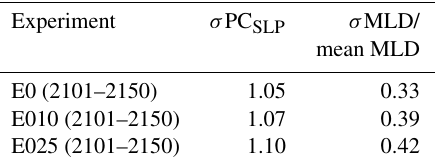
Table 3. Variation in the wintertime (DJFM) atmospheric forcing over the NE Atlantic during the shallow-ML regime as the standard deviation of the projection of the SLP composite pattern (Fig. 13) on the unprocessed SLP time series ( σ PC SLP ) and the ratio between the variability and the mean of the March MLD at the Celtic shelf break ( σ MLD/mean MLD). Ensemble spread for E0 and E010 is about ± 10%. The relation between SLP and MLD anomalies is ex- plained in Sect. 3.2.